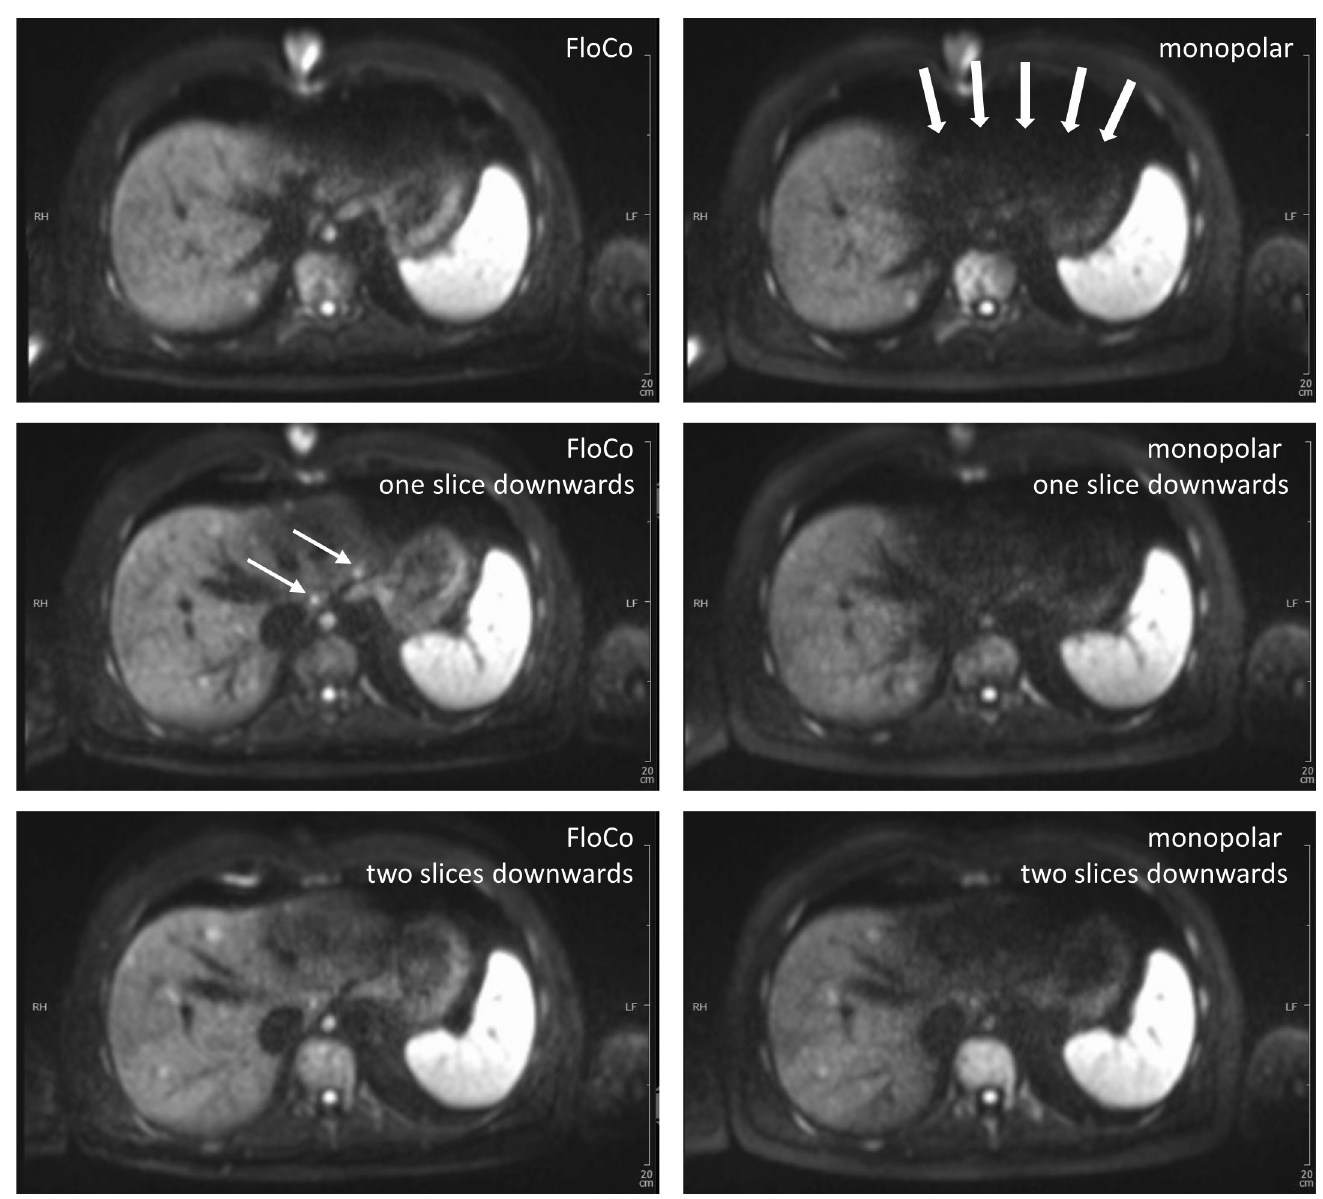
Fig 2. Diffusion-weighted b800 images of the liver in a 42-year-old patient with metastatic medullary thyroid carcinoma. Three adjacent slices, left-side flow- compensated (FloCo), right-side conventional monopolar diffusion encoding. There are considerable pulsation artifacts with monopolar diffusion encoding, which mask focal lesions in the left liver lobe (thick arrows). One of the arrow-marked small lesions was not reported by either of the two readers in the monopolar dataset. The other arrow-marked small lesion was not reported by one of the readers in the monopolar dataset. were approximately 30% higher with FloCo than with monopolar encoding. In the right liver lobe, the effect size was less, with approximately 10% to 15% increased SNR with FloCo than with monopolar encoding. The quantitative difference between the monopolar and FloCo ADCs was small, but the mixed ADC (calculated with b50-Monopolar and b800-FloCo) was reduced by approximately 15%. The differences between the three ADCs (Monopolar, FloCo, and Mixed) were significant (for the left and right liver lobe). The post hoc evaluation revealed no significant differences between monopolar and FloCo ADCs (in